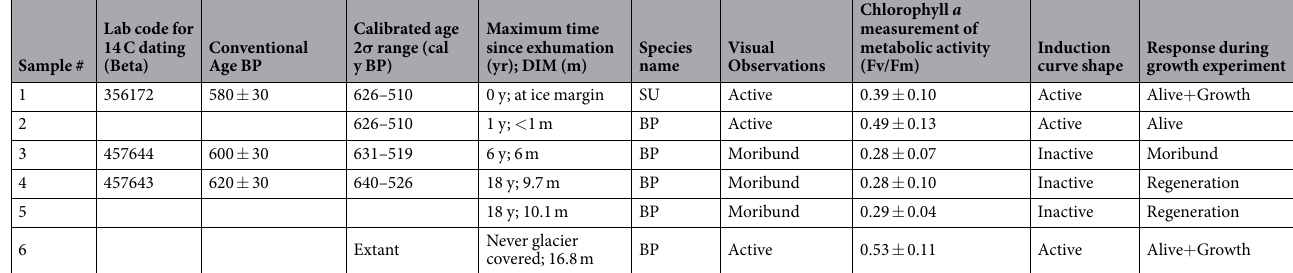
exposed sample of S. uncinata (n. 1) exhibiting growth (Table 1, Fig. 2F,H), and growth occurred from the stem apex in both the latter cases (without any protonemal or rhizoid initial growth). Among the moribund mosses, sample n. 3 became marcescent and covered by fungal hyphae, and did not show any regeneration (Table 1), whereas the other two moribund samples (n. 4, 5) exhibited regeneration (Fig. 2C–E,G), with growth of leaves at the branch apices in existing gametophyte shoots (Table 1).